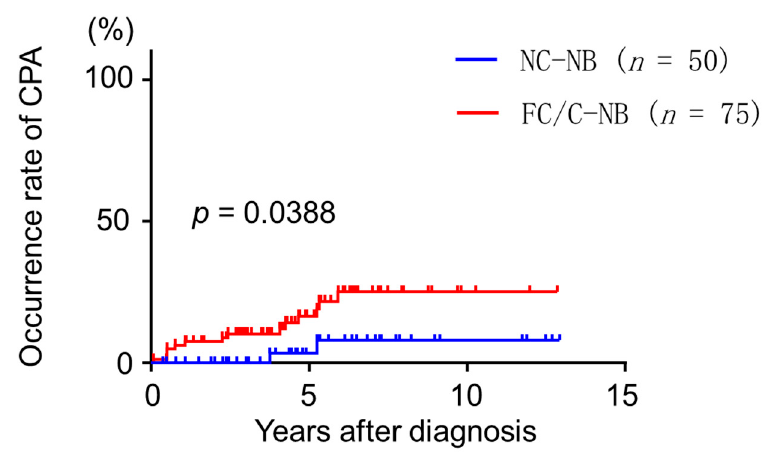
Figure 2. Occurrence rate of chronic pulmonary aspergillosis after diagnosis of Mycobacterium avium complex pulmonary disease. CPA, chronic pulmonary aspergillosis, NC-NB, non-cavitary nodular bronchiectasis; FC, fibrocavitary form; C-NB, cavitary nodular bronchiectasis.